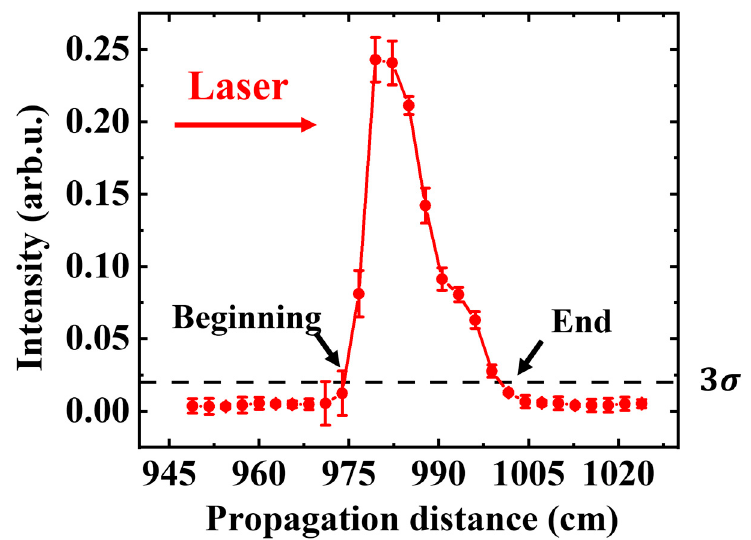
Figure 3. Peak amplitude of the acoustic signal at different positions in the absence of artificial turbulence (the red line represents the 3 times standard deviations of ambient noise (3 σ )).